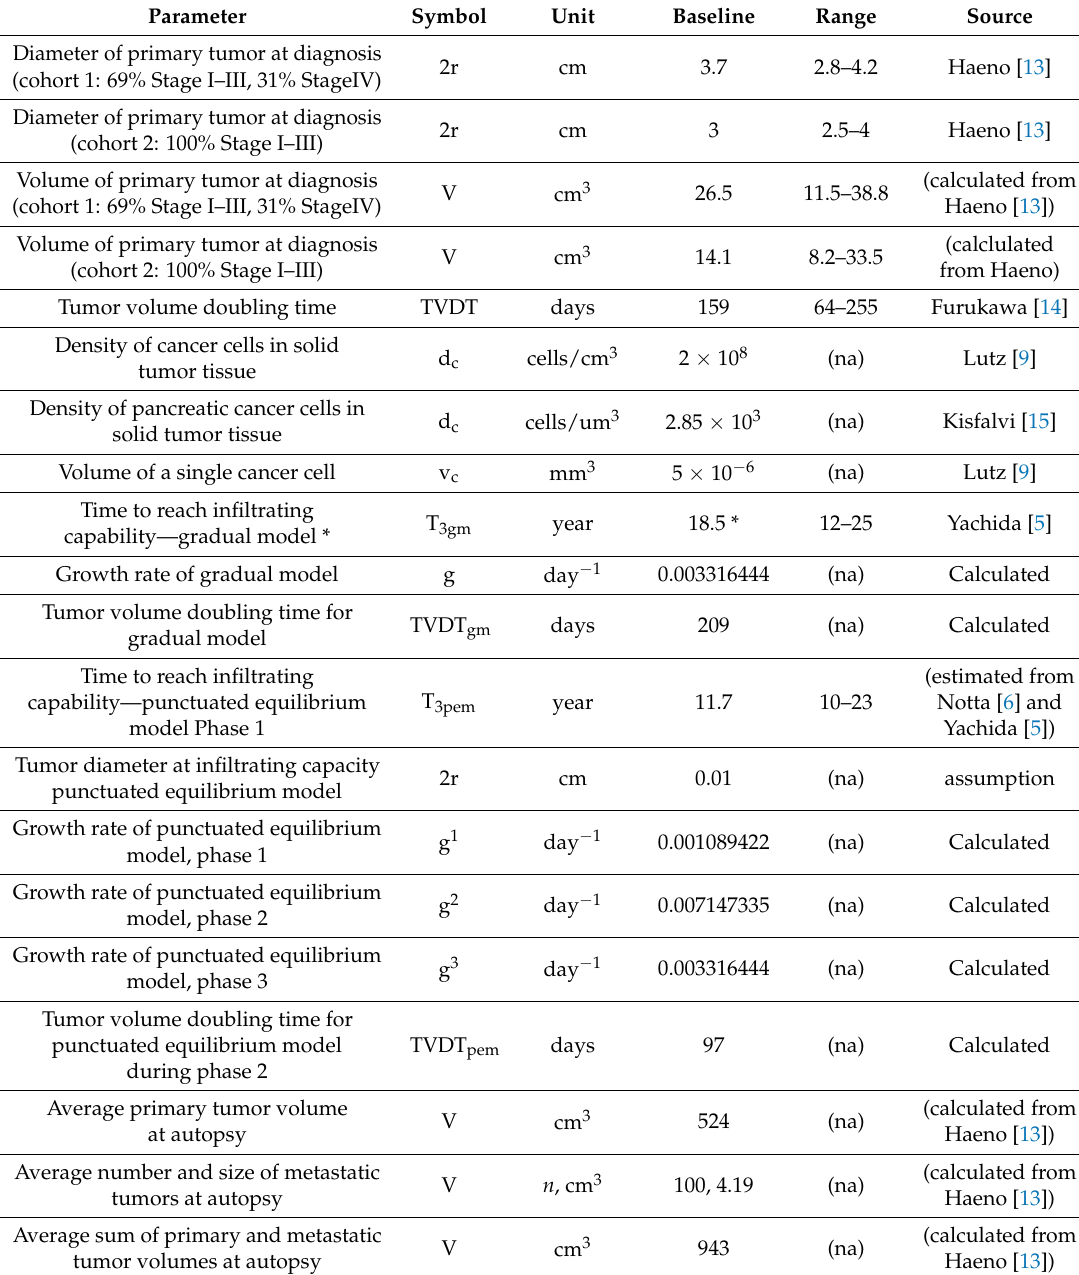
Table 1. Tumor growth model parameters, input value ranges (if applicable), and sources. Parameter Symbol Unit Baseline Range